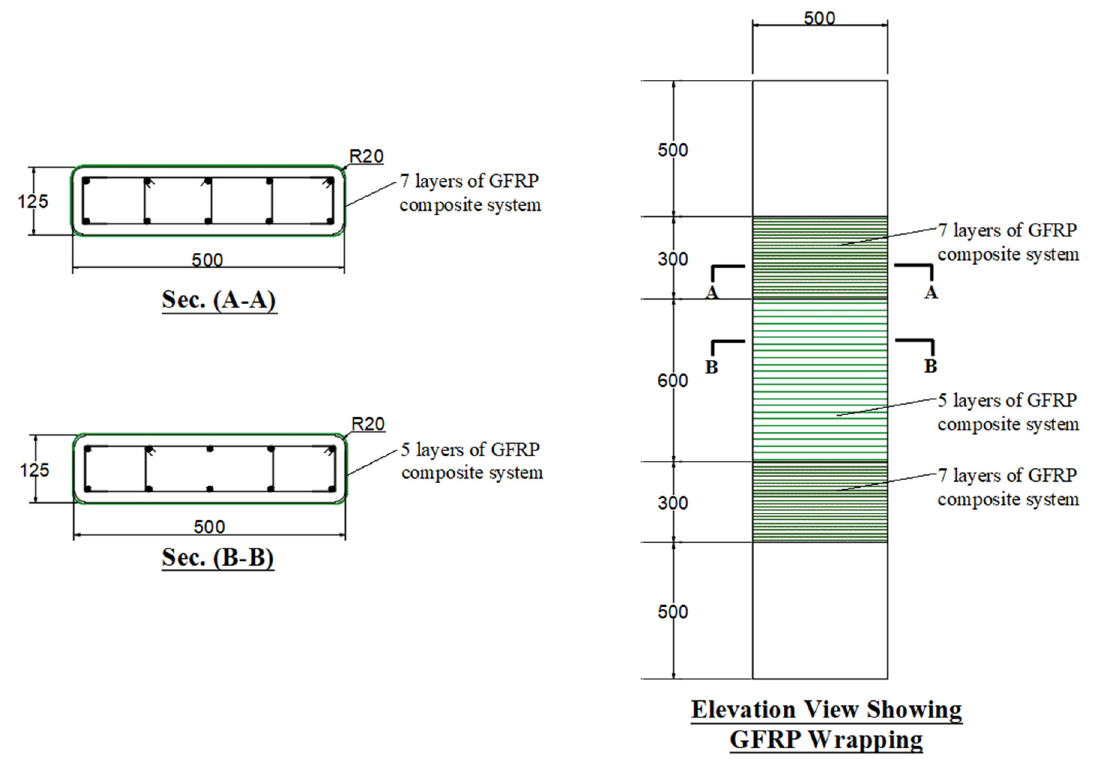
Figure 2. Details of strengthened column S1 (units of dimensions = mm).